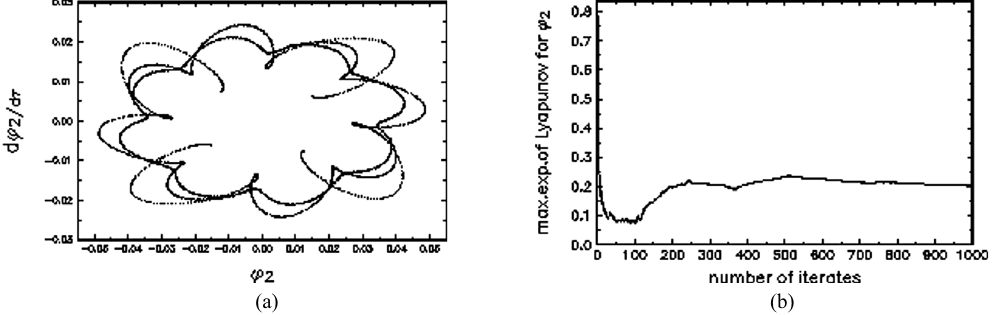
Fig. 14. Poincaré map (a) and Lyapunov exponents (b) of ϕ 2 for γ 4 = 0.0005 and for: a 1 = a 2 = 0.1; a 3 = 0.0001; γ 1 = 0.0001; γ 2 = γ 3 = 0; β 1 = 0.65; c = 1; u 1 = u 2 = 1.5; q =